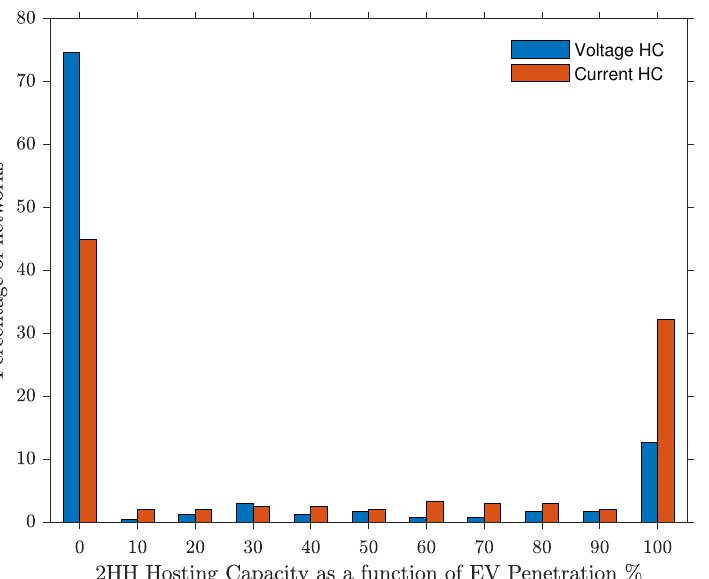
Figure 10. Percentage of branches with voltage ( left -axis) and current ( right -axis) constraints for 0.1HH, 2HH, and 48HH as a function of EV penetration, aggregated over the 236 networks.